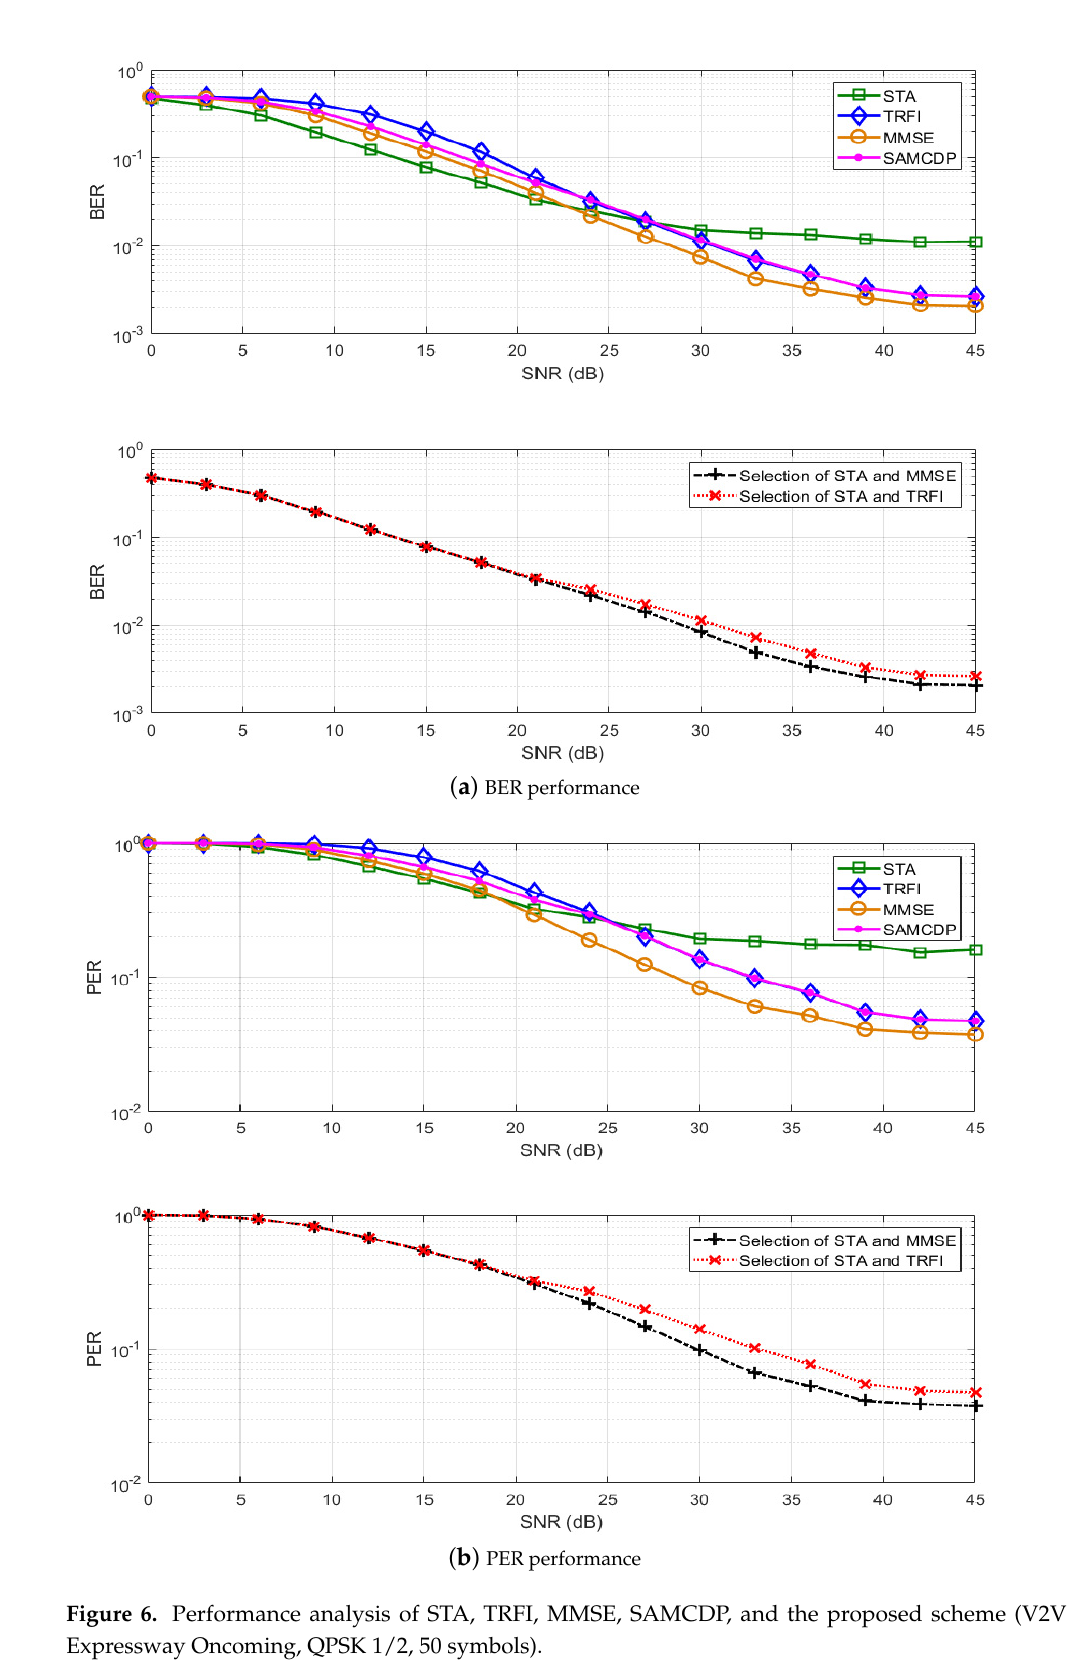
Figure 6. Performance analysis of STA, TRFI, MMSE, SAMCDP, and the proposed scheme (V2V Expressway Oncoming, QPSK 1/2, 50